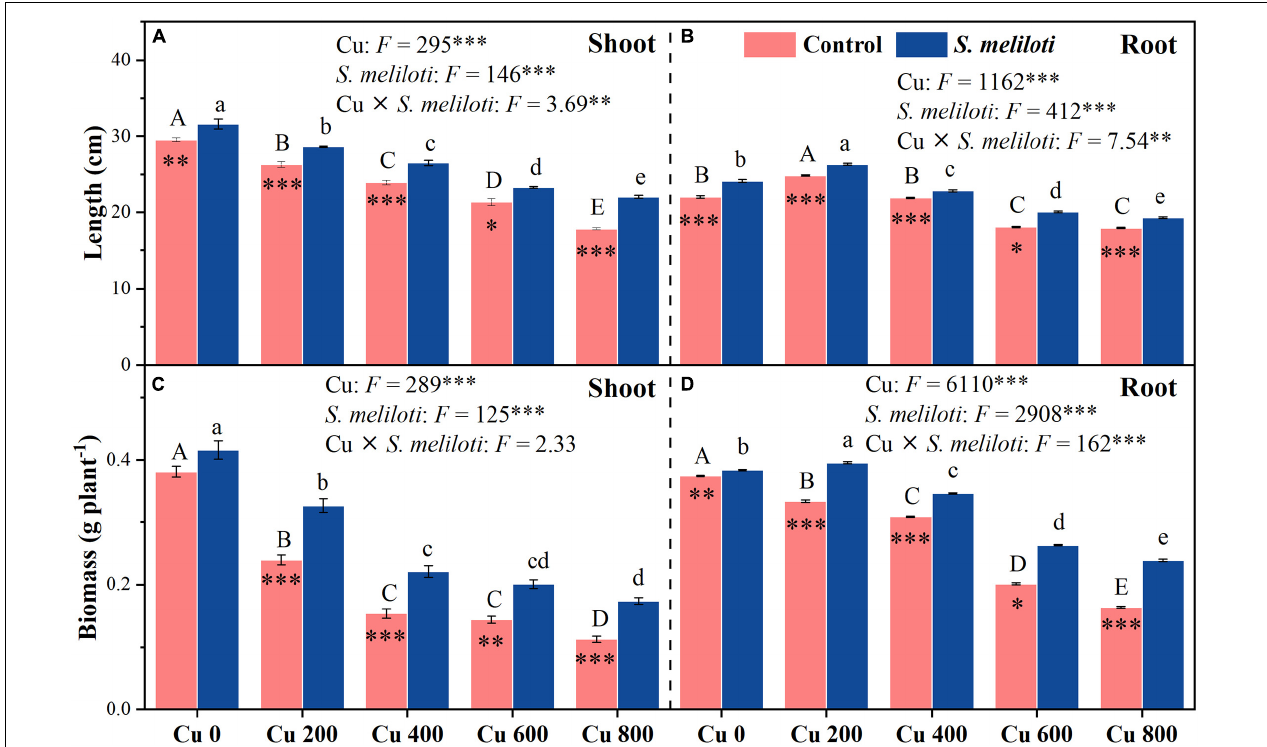
FIGURE 1 | The effect of inoculation with S. meliloti on length and biomass in the shoot (left panel) and root (right panel) of alfalfa with different Cu concentration treatments. The capitalized (Cu) and lowercase ( S. meliloti ) letters above the bars indicate significant difference between different Cu concentrations ( P < 0.05). The asterisks indicate significant differences between non-inoculated and inoculated alfalfa under the same Cu concentration condition. Each value represents the mean ± SE ( n = 3). *** P < 0.001; ** P < 0.01; * P < 0.05.